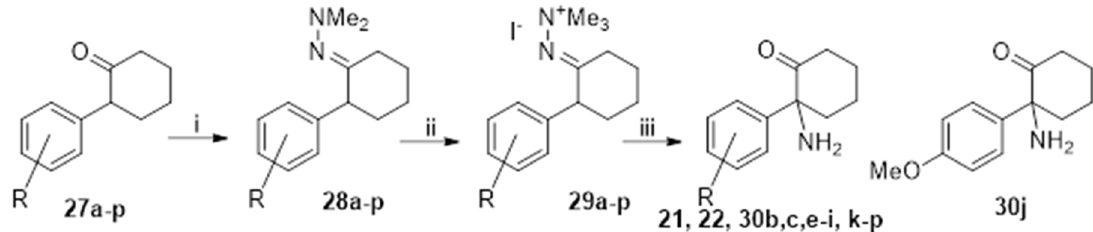
Figure 2. Known norketamine